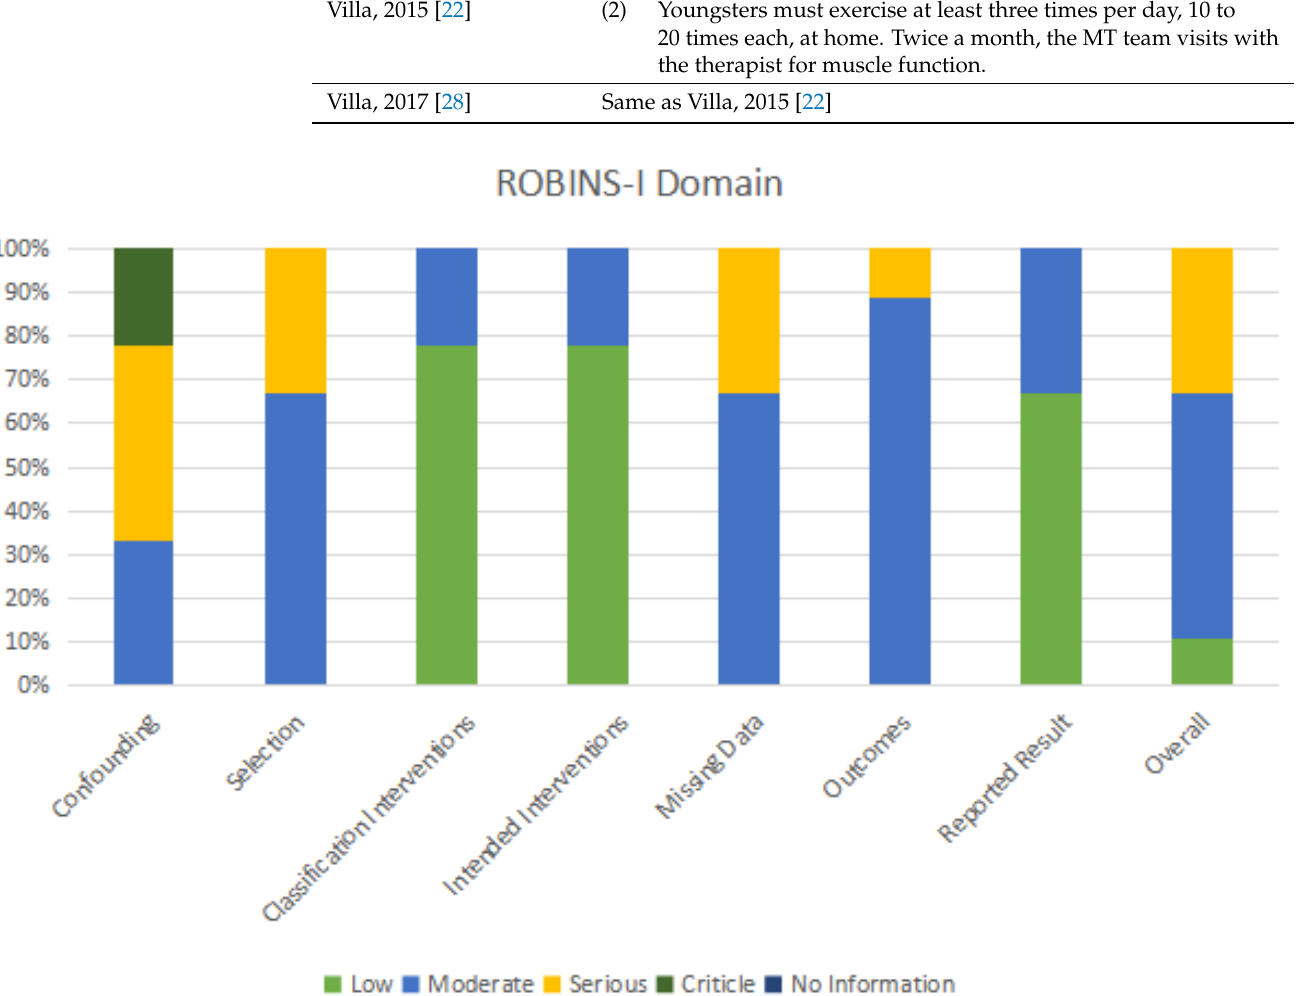
Figure 2. Utilizing the ROBINS-I instrument to assess bias risk. Table 5. OMT intervention plan.